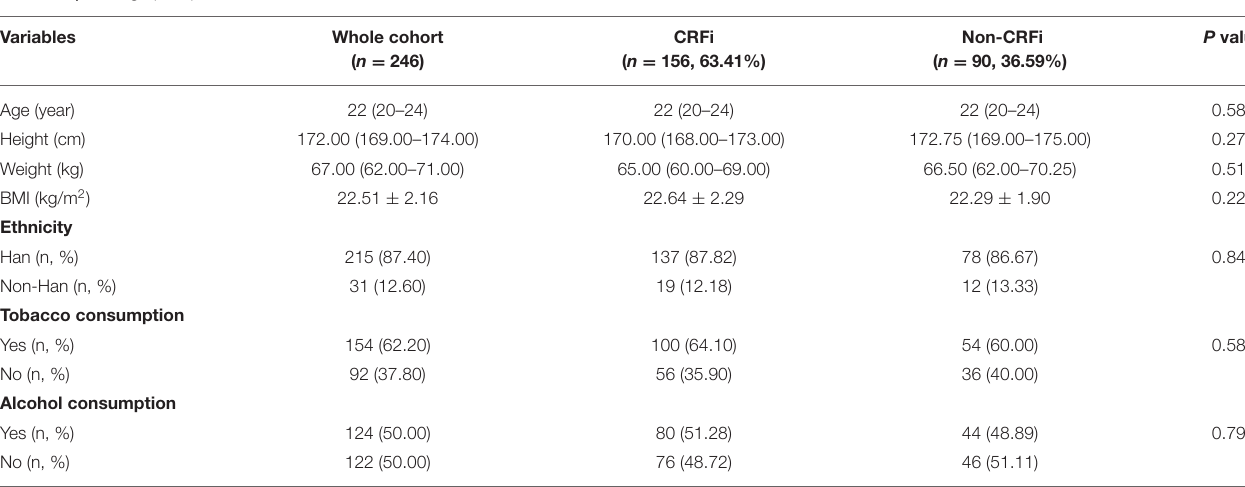
TABLE 1 | Demographic